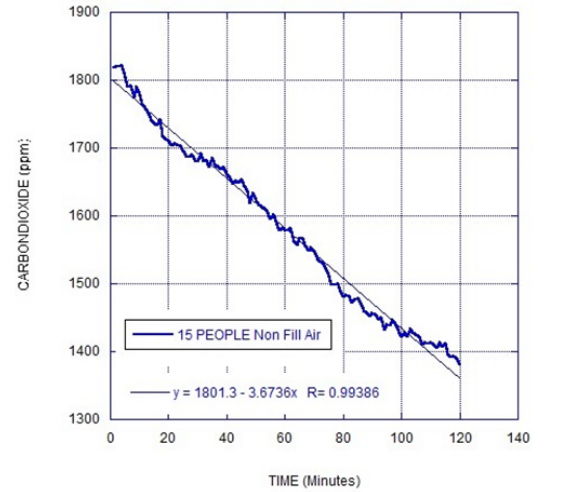
Figure 2. Decreasing rates of CO 2 in the experimental room